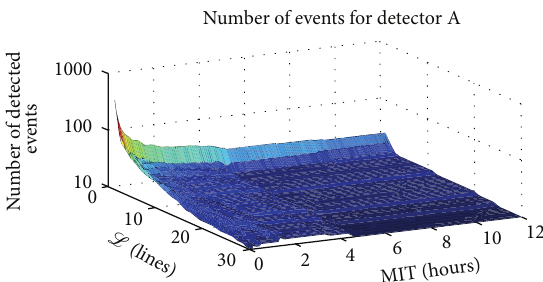
Figure 4: A plot showing the number of events as a function of MIT and L for detector A for data taken between February 23, 2014, 16:04 UTC and April 19, 2014 12:43 UTC. Clearly, increasing either MIT or L can substantially decrease the number of identified rain events. Note that the decrease in event count is not strictly monotonic with increasing MIT; even though merging “possible events” may decrease the total number of events, it is also possible that an increase in MIT will keep a potential event “alive” long enoughtoobtaintheminimumnumberofminuteobservationswith tips L . Increasing L while holding MIT fixed does monotonically decrease the number of observed